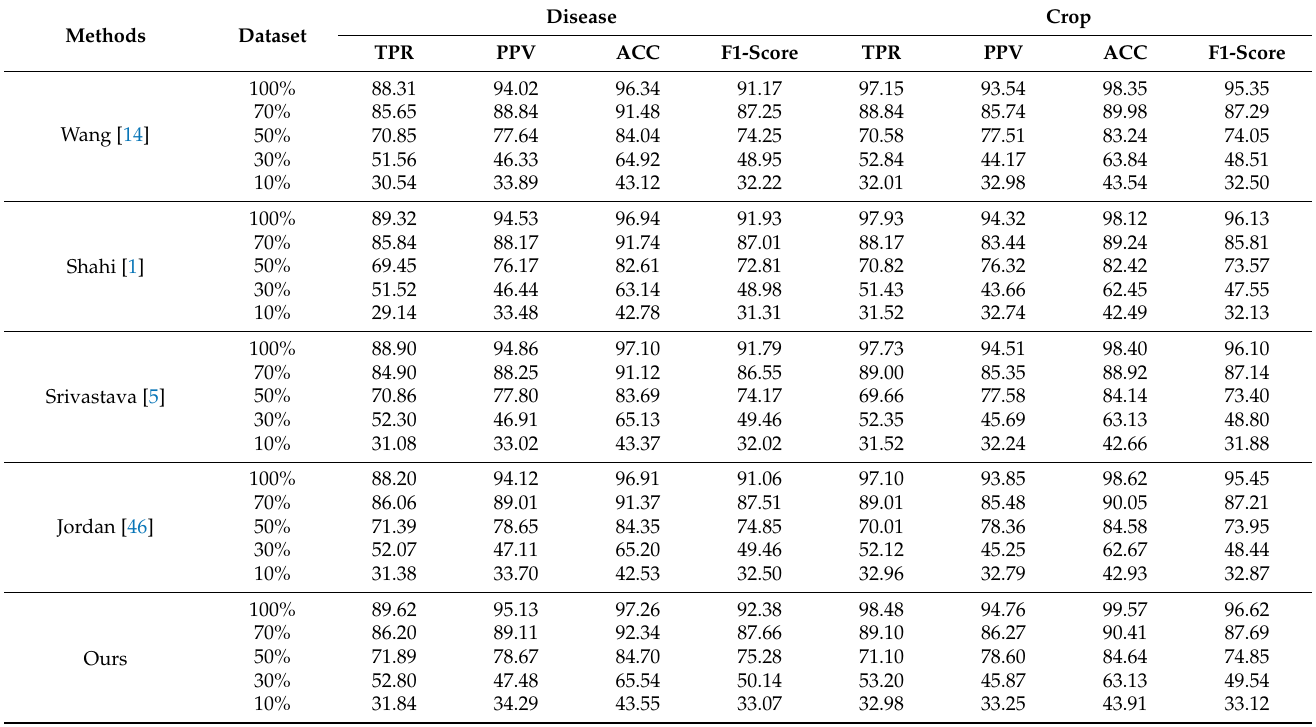
Table 31. Comparison of accuracies achieved by the proposed PI-CNN and the existing methods in the original and reduced datasets. The accuracies were achieved in the PlantVillage dataset (unit: %).